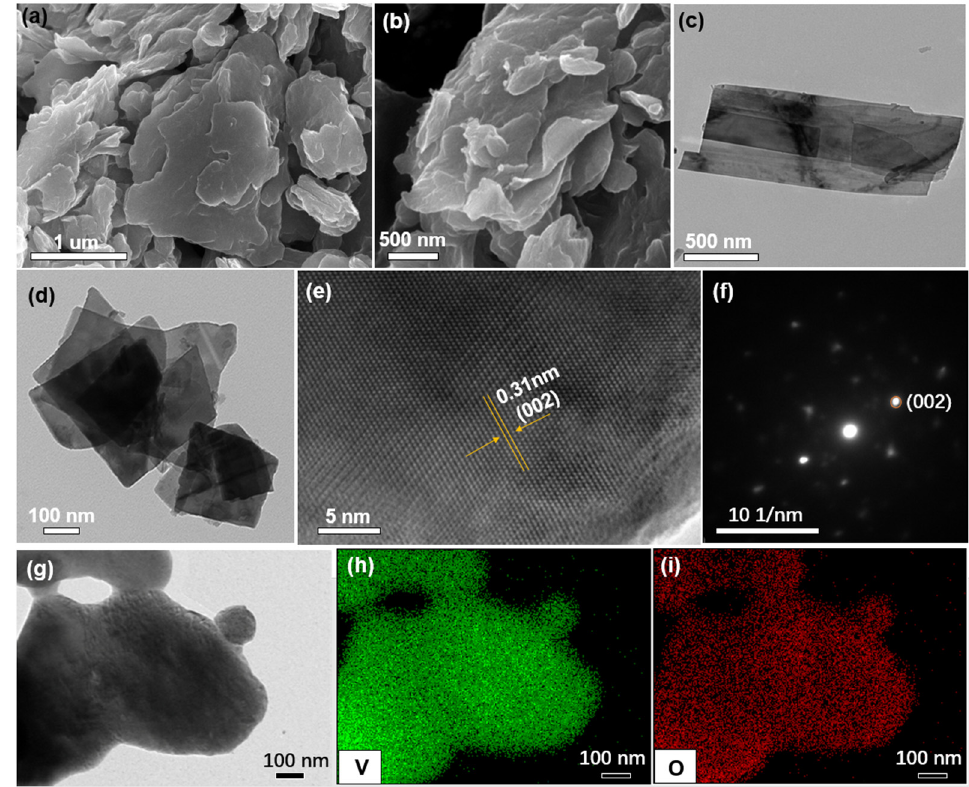
Figure 3. The morphology of VO 2 2D-nanosheets: ( a , b ) SEM images; ( c , d ) TEM images; ( e ) HR-TEM image; ( f ) SAED pattern; ( g – i ) TEM image and corresponding element mappings of V and O.